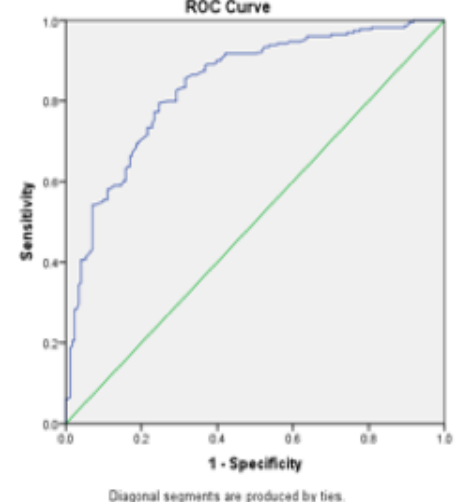
Fig. 4: ROC curve for right hand index of